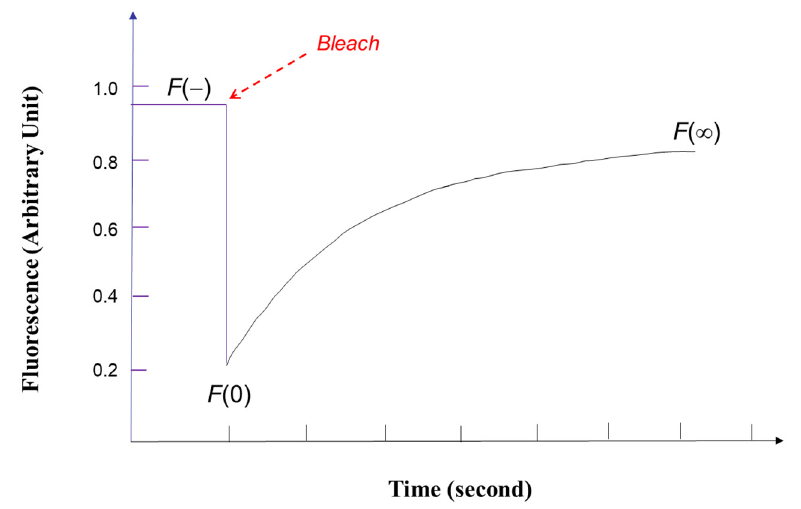
Figure 2. The fluorescence intensity measured by a CCD camera or PMT before and after photo- bleaching during FRAP experiments. bleaching during FRAP